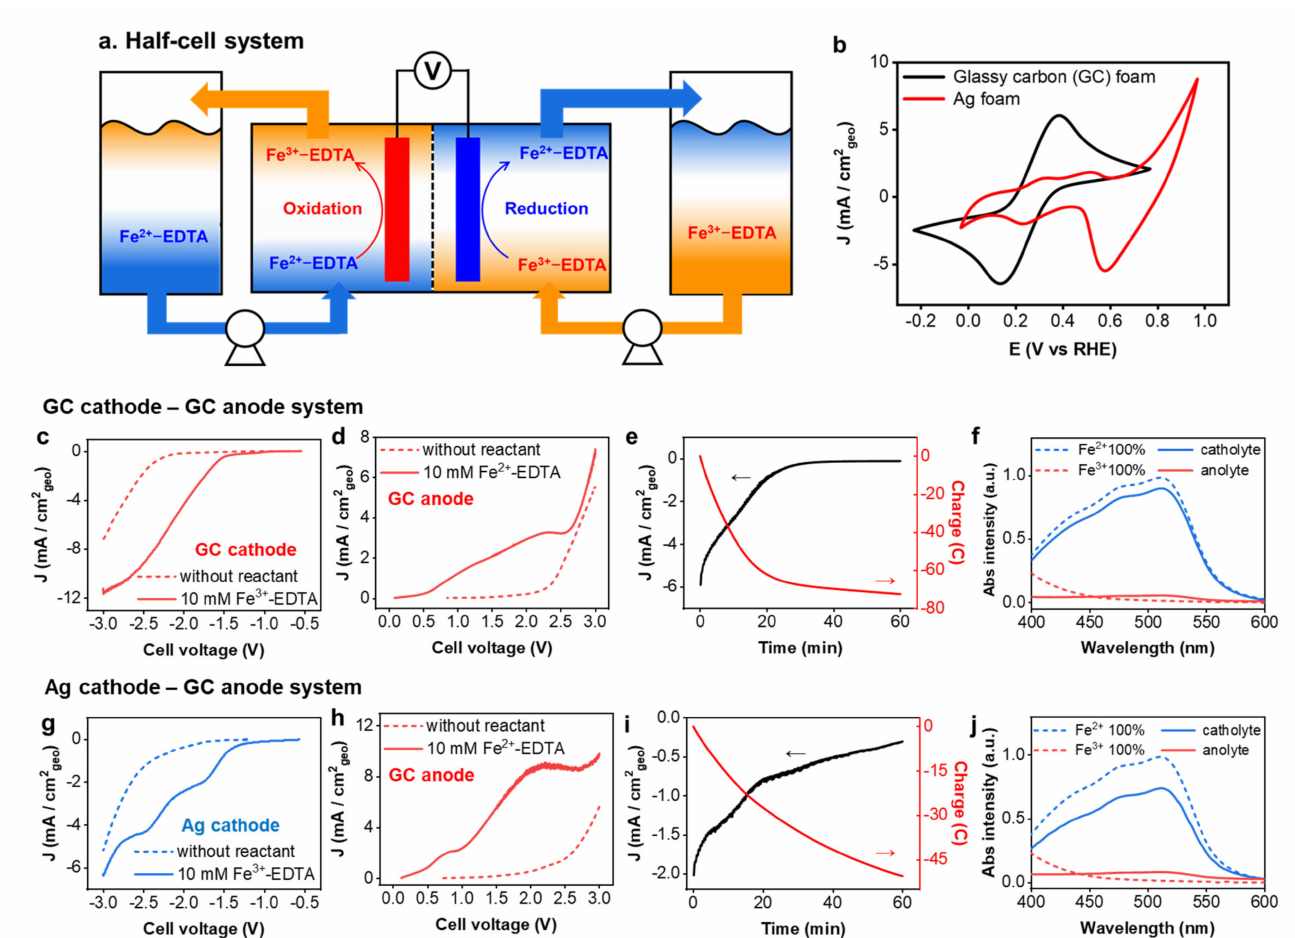
Figure 3. ( a ) schematic description of half-cell system to examine the electrochemical Fe-EDTA conversion. ( b ) CV curves of glassy carbon (GC) and Ag foam electrodes in 10 mM Fe 2+ -EDTA dissolved 0.1 M Na 2 SO 4 aqueous solution (pH 2.7) with a scan rate of 10 mV s − 1 . The linear sweep voltammetry (LSV) curves of ( c ) 10 mM Fe 3+ -EDTA reduction and ( d ) 10 mM Fe 2+ -EDTA oxidation using GC foam cathode and anodes in the half-cell system. ( e ) J-t and C-t curves of the constant potential half-cell reduction reaction at − 2.0 V using GC foam as a working electrode in the half-cell system. ( f ) UV/Vis absorption spectra to determine of Fe 2+ and Fe 3+ ratio in the electrolyte after the constant potential half-cell reaction (solid lines). The dotted lines represent reference UV/Vis spectra corresponding to 100% of Fe 2+ and Fe 3+ ratio. The linear sweep voltammetry (LSV) curves of ( g ) 10 mM Fe 3+ -EDTA reduction using Ag foam cathode and ( h ) 10 mM Fe 2+ -EDTA oxidation using GC foam anode in the half-cell system. ( i ) J-t and C-t curves of the constant potential half-cell reduction reaction at − 1.5 V using Ag foam as a working electrode in the half-cell system. ( j ) UV/Vis absorption spectra of electrolyte after the constant potential half-cell reaction. All the LSV curves were obtained with a scan rate of 10 mV s − 1 . The flow rate of electrolyte circulation was 4 mL min − 1